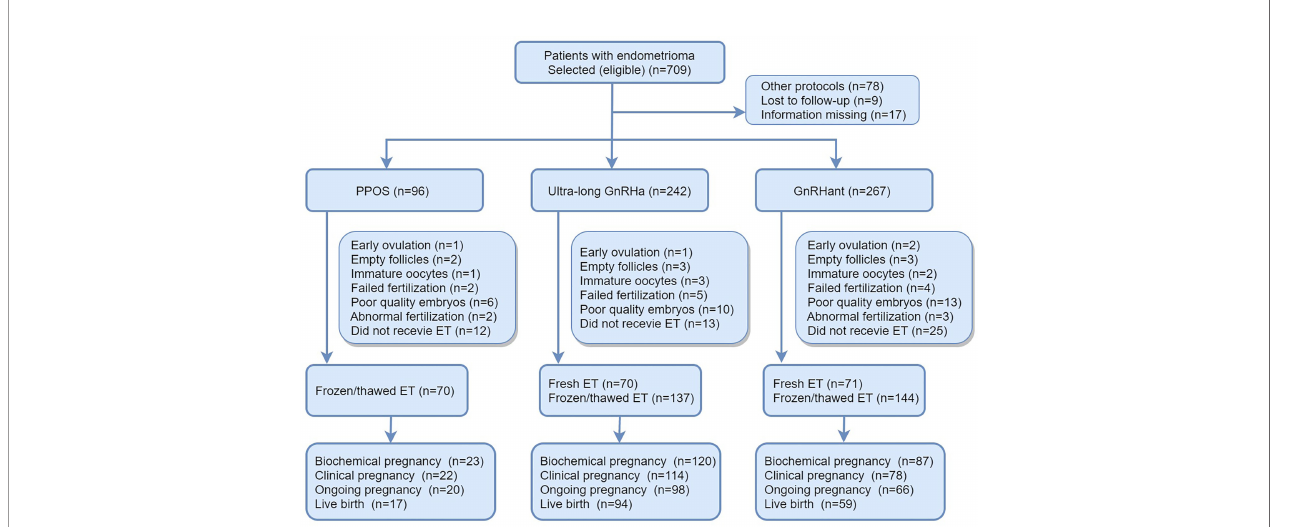
FIGURE 1 | Details of fl owchart of participants and main reproductive outcomes of the enrolled patients. PPOS, progestin-primed ovarian stimulation; GnRHa, gonadotrophin-releasing hormone agonist; GnRHant, gonadotrophin-releasing hormone antagonist; ET, embryo transfer.